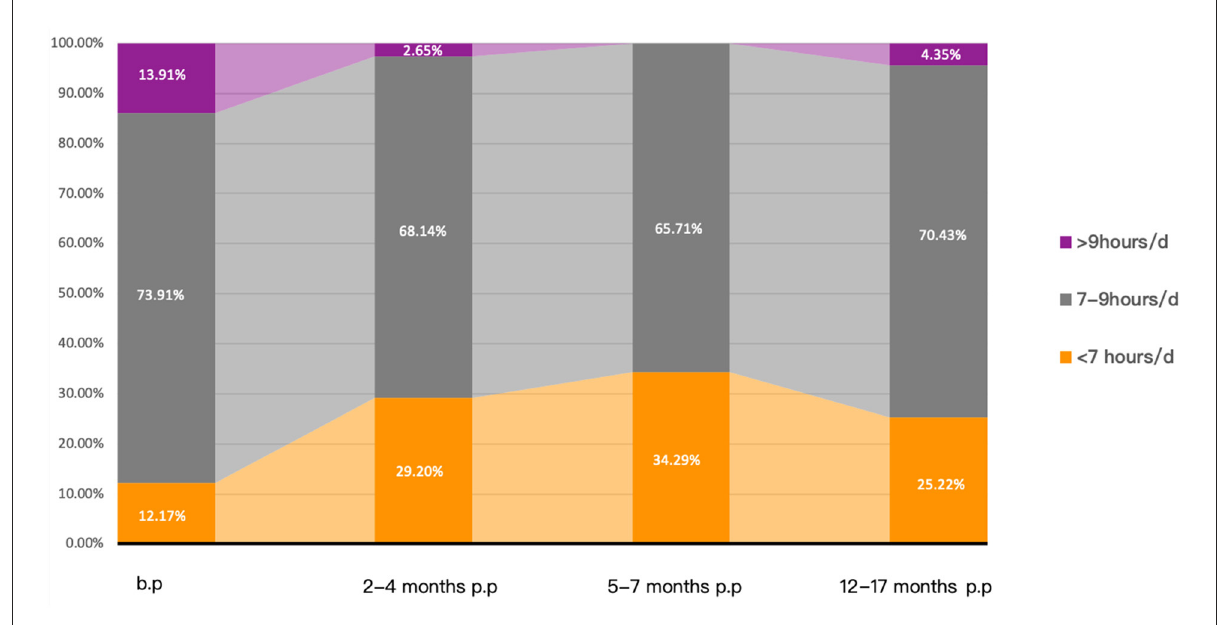
FIGURE3 Percentage distribution of sleep duration. b.p, before pregnancy; p.p,